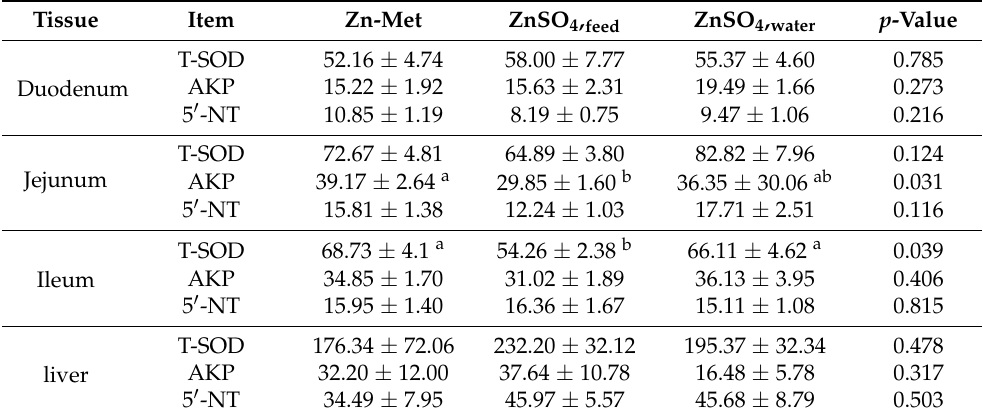
Table 5. Effect of different Zn supplementation forms on Zn-containing enzymes in the duodenum, jejunum, ileum, and liver of the piglets.